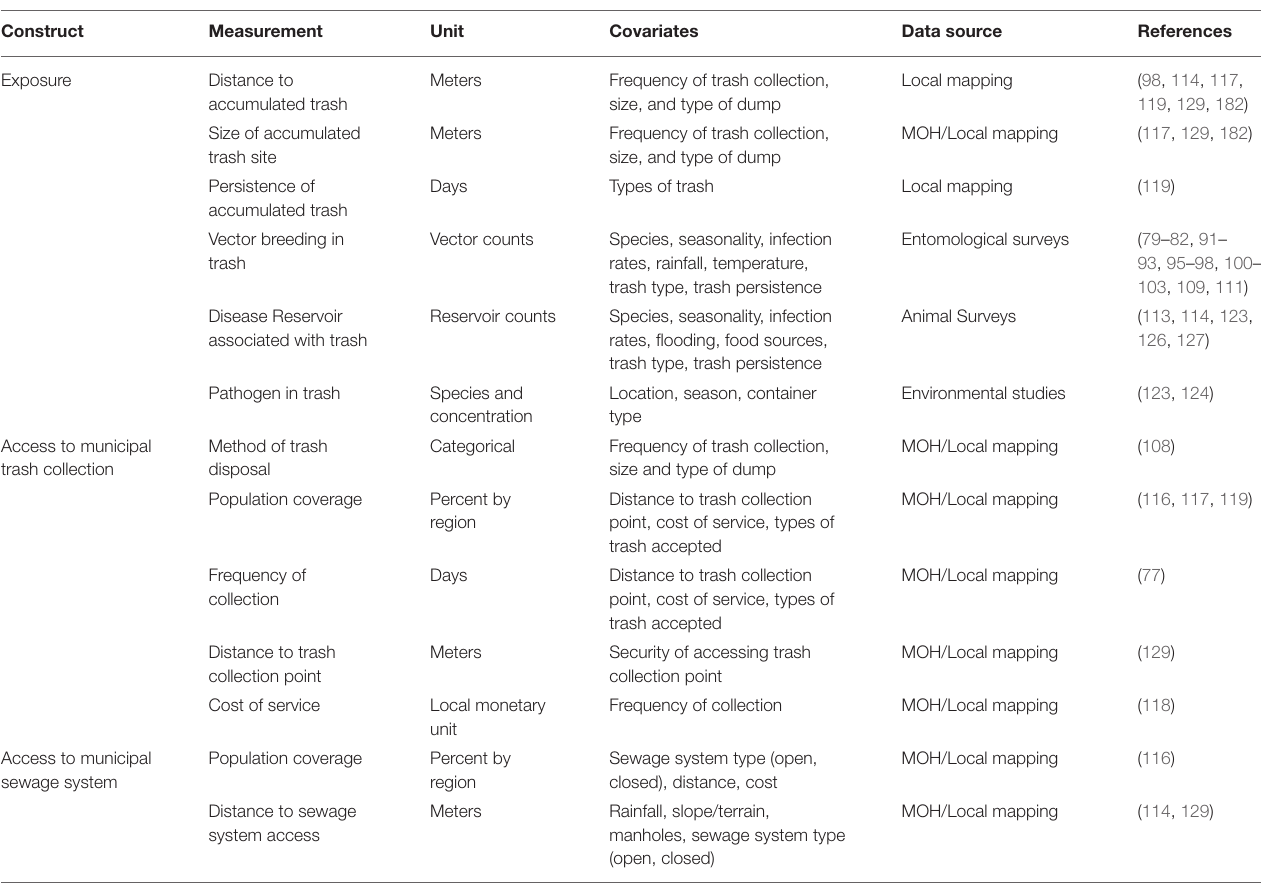
TABLE 3 | Standardized measurements to define and quantify exposure to solid